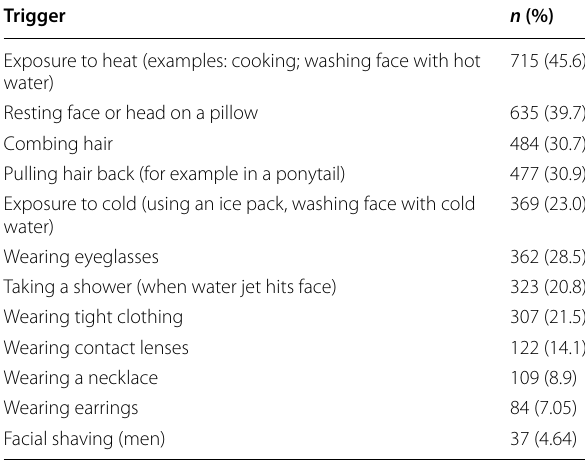
Table 2 Sensory stimuli usually exacerbating headache or triggering allodynia in MwoA patients